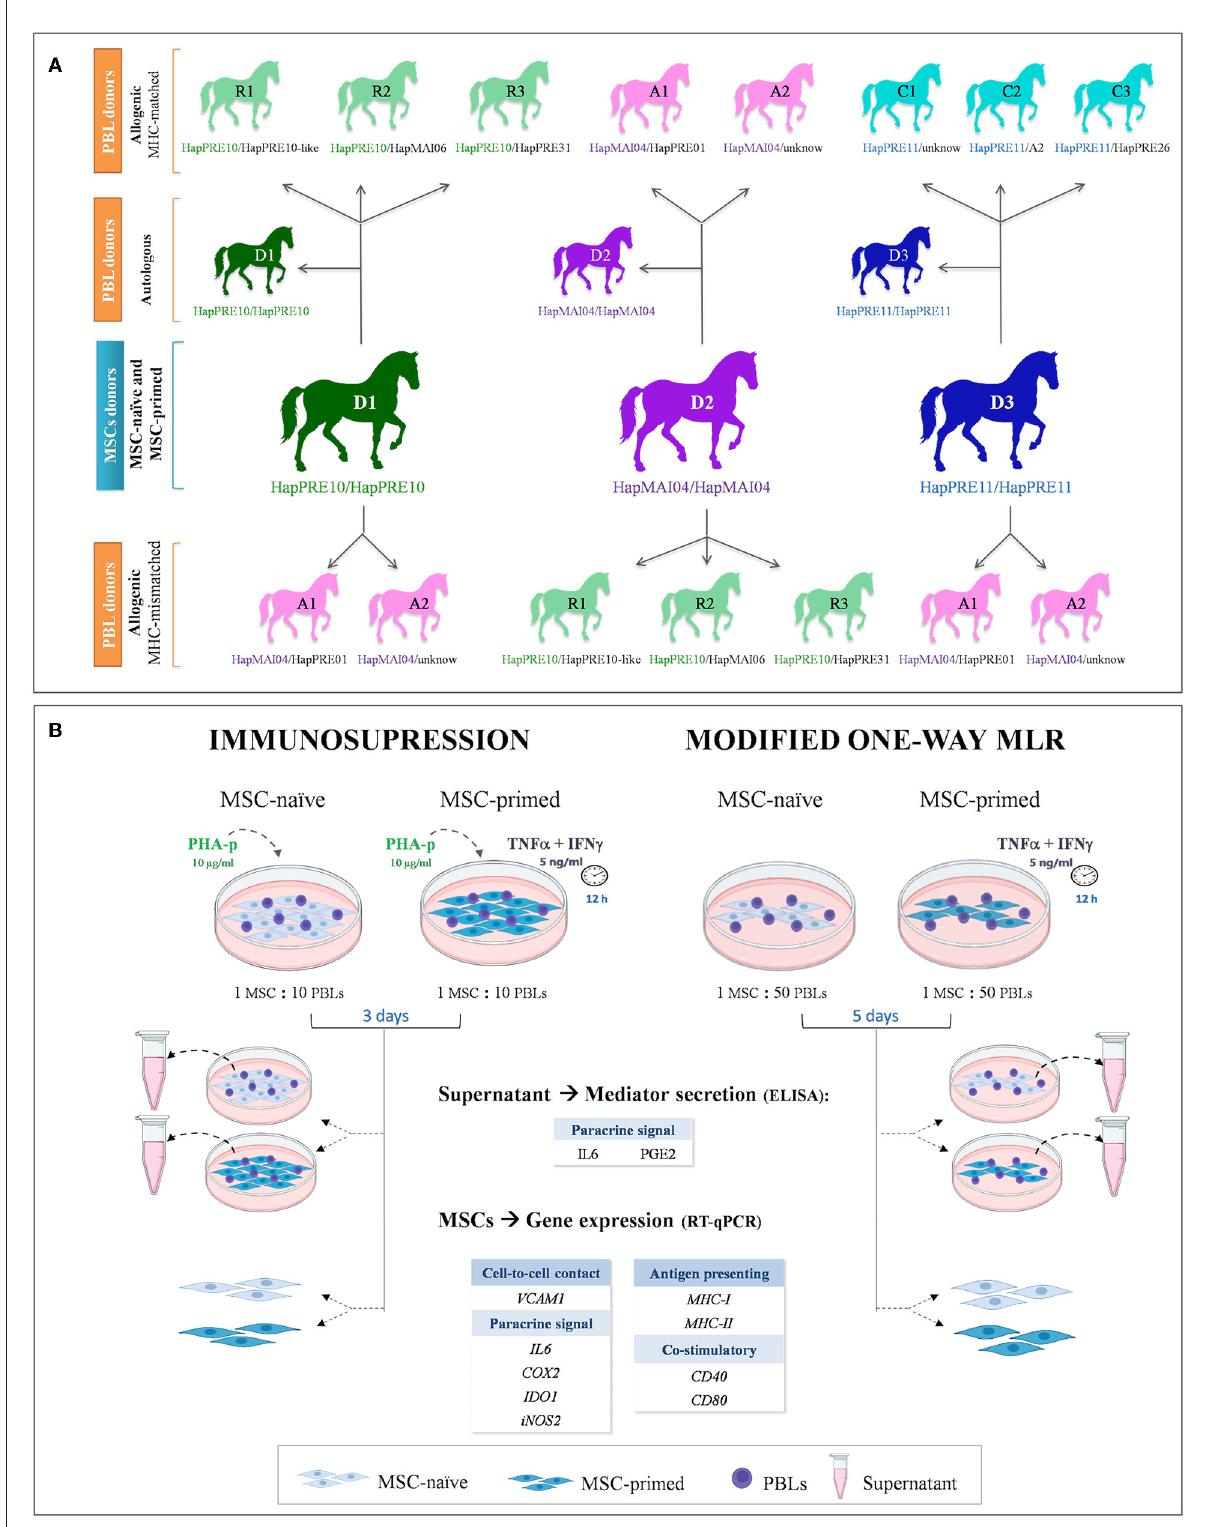
FIGURE1 Study design. (A) Equine donors of mesenchymal stem cells (MSCs) and peripheral blood lymphocytes (PBLs) are presented with their ELA haplotypes and the combinations to establish autologous and allogeneic major histocompatibility complex (MHC)-matched and MHC-mismatched co-cultures. (B) Equine MSCs were assayed with unstimulated (MSC-naive) and primed with cytokines (MSC-primed)